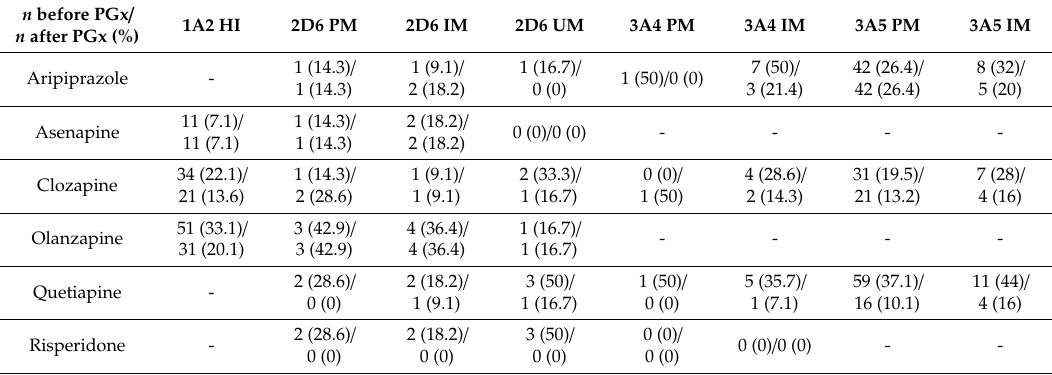
Table 8. Number of cases (and percentage of the total of individuals presenting each specific phenotype) prescribed with and antipsychotic metabolized by an altered pathway.